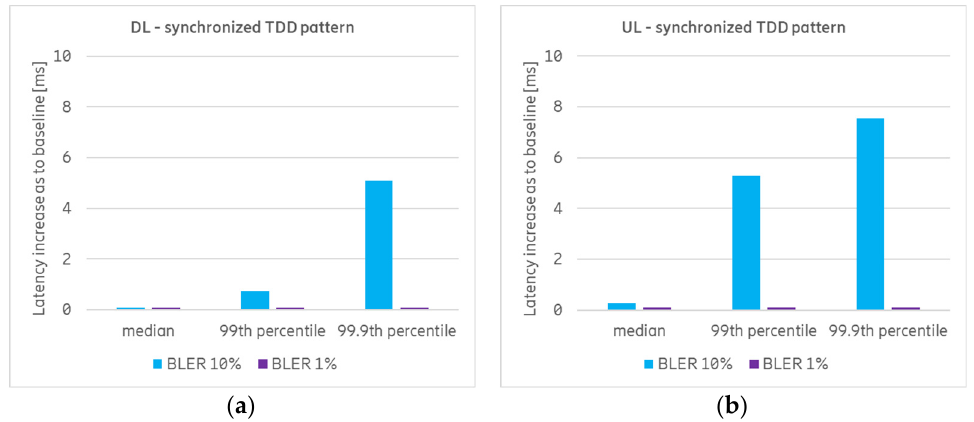
Figure 9. DL ( a ) and UL ( b ) latency increase compared to their baseline for synchronized TDD pattern when using different BLER targets in the worst-case deployment setup.